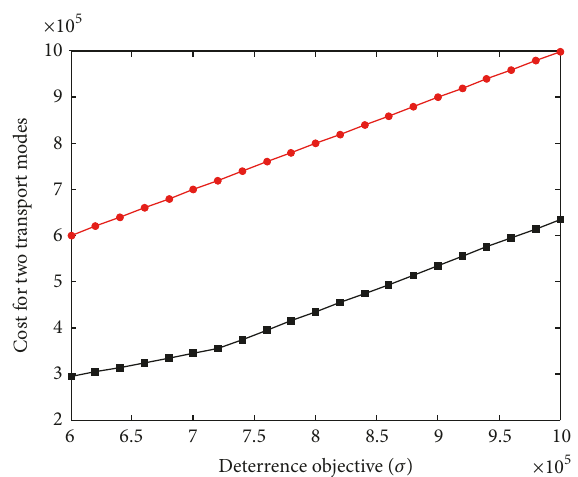
Figure 5: Total transport cost for the two carriers varying with the deterrence objective. Black square for carrier 1 (shipping); red circle for carrier 2 (railway).